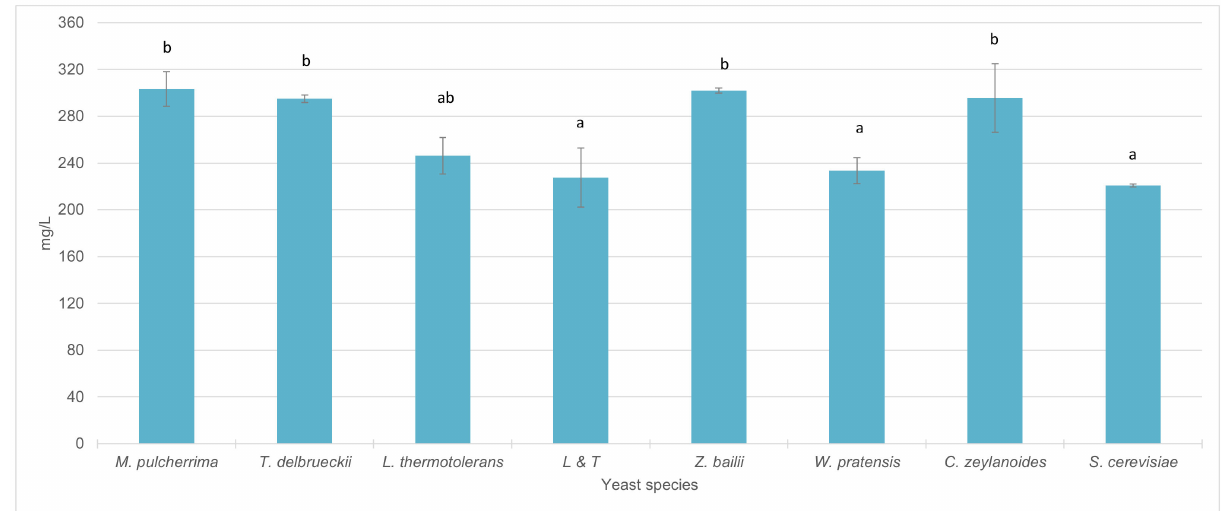
Figure 3. Total anthocyanin content (mg/L) in wines sequentially fermented with different yeast species. (Average of the different strains in each species included in the study). Different letters mean significant differences between the samples ( p ≤